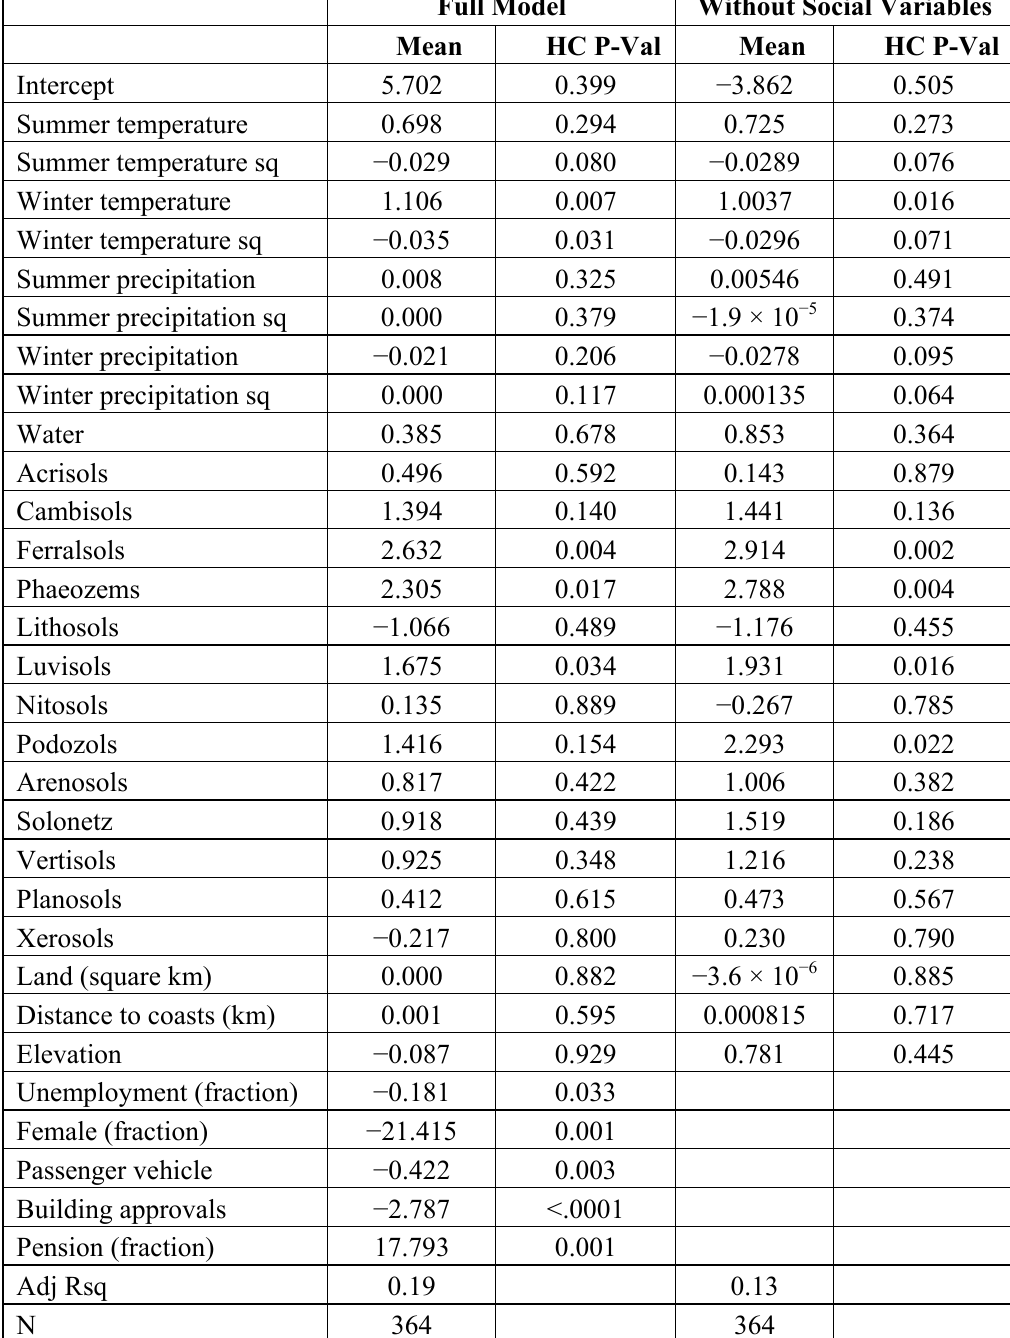
Table 4. The number of dairy cattle (in log) per 1,000 rural